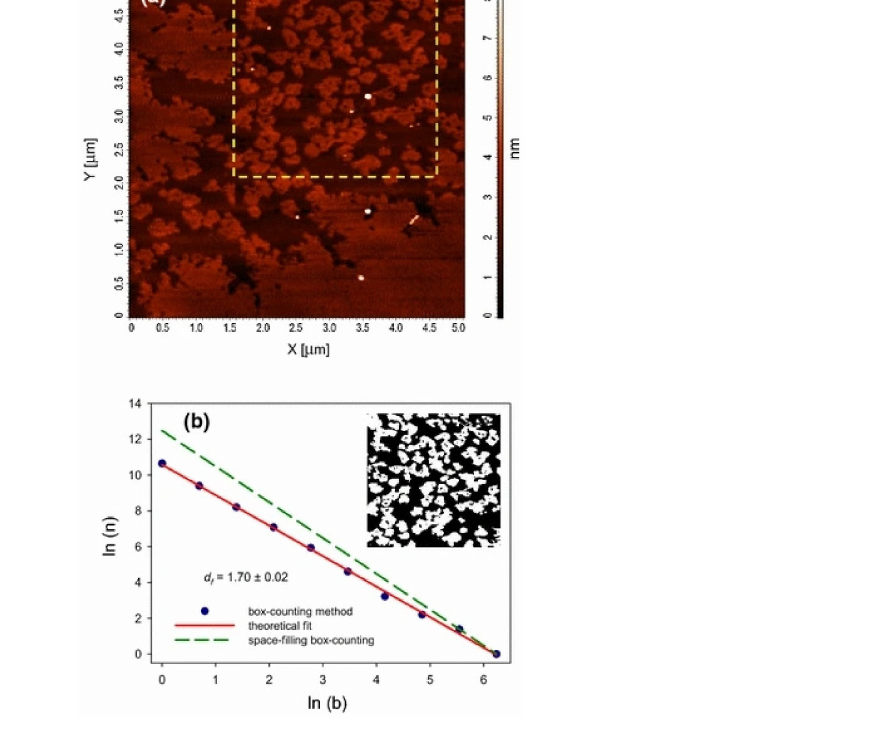
Figure 6. An AFM image ( a ) and its fractal dimension ( b ) of a rosette-shaped fractal structure limited by a plain